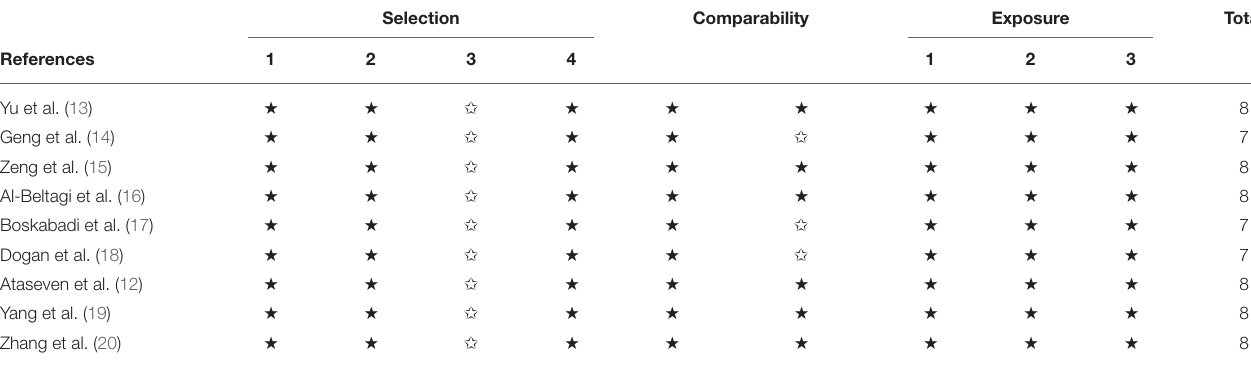
TABLE 3 | NOS score of studies included in this